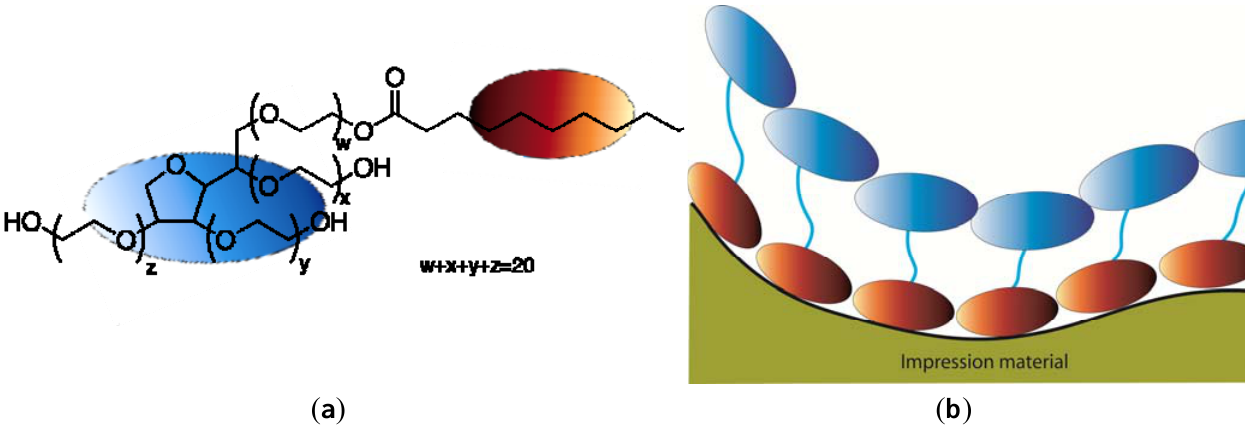
Figure 9. ( a ) Chemical formula of Tween 20; ( b ) Tween 20 interacting with the impression surface. Orange ellipses: hydrophobic part; Blue ellipses: hydrophilic